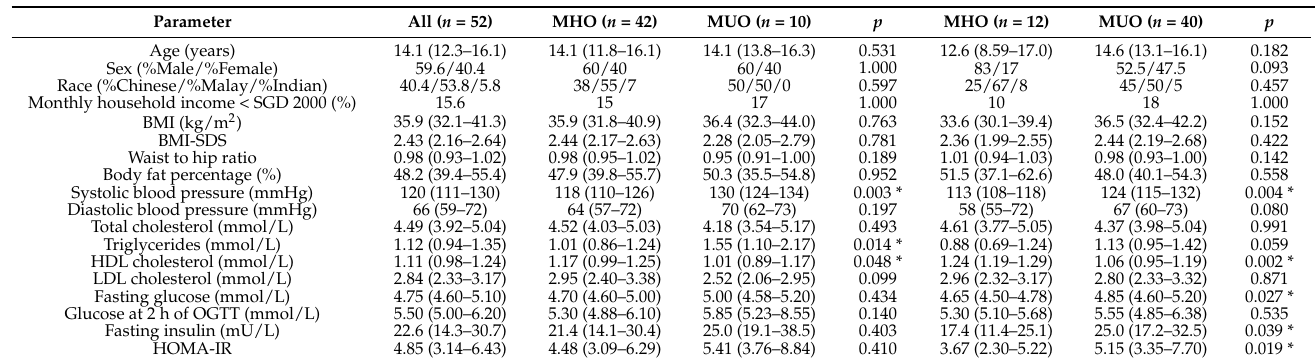
Table 1. Clinical characteristics between children/adolescents with MHO and children/adolescents with MUO classified by MS and MH definitions.